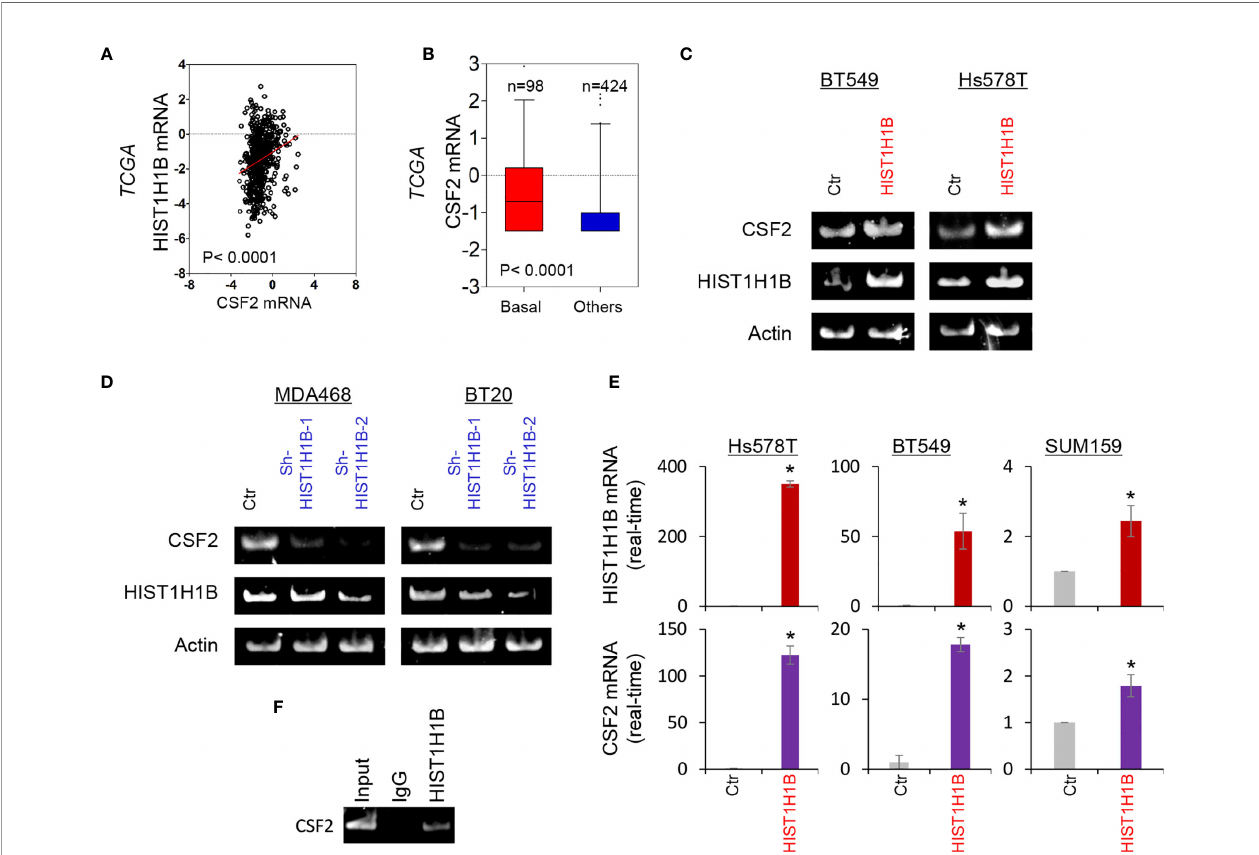
FIGURE 4 | HIST1H1B promotes CSF2 expression. (A) Analysis of the TCGA dataset for the expression of HIST1H1B and CSF2. The relative level of HIST1H1B is plotted against that of CSF2. (B) Box-plots indicated CSF2 mRNA expression in different subtypes of breast cancer from the TCGA dataset. (C, D) Expression of HIST1H1B and CSF2 was analyzed by semi-quantitative RT-PCR in SUM159, Hs578T and BT549 cells with empty vector or HIST1H1B expression (C) as well as MDA-MB468 and BT20 cells with stable empty vector or knockdown of HIST1H1B expression (D) . Data are shown as mean ± SD based on three independent experiments. *P < 0.05 by Student's t test. (E) Expression of HIST1H1B and CSF2 mRNA was examined by quantitative real-time PCR in Hs578T, BT549 and SUM159 cells with stable empty vector or HIST1H1B expression. (F) ChiP analysis for binding of HIST1H1B to the CSF2 promoter in SUM159